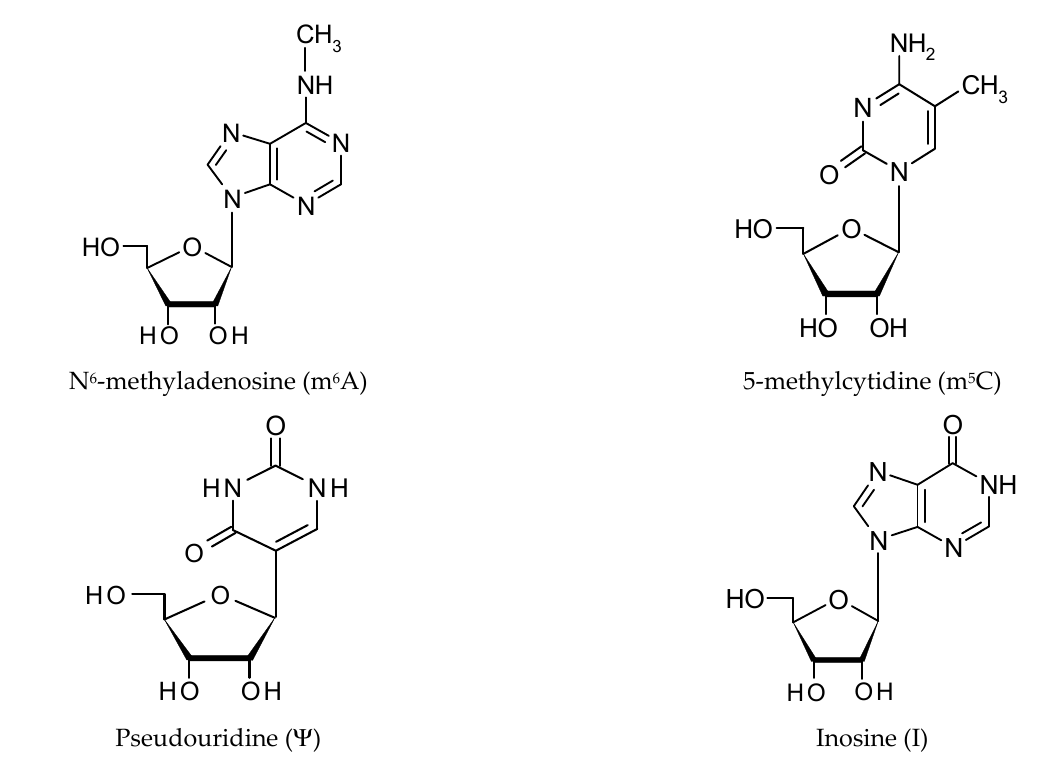
Figure 1. The structure of modified nucleotides found in eukaryotic lncRNA molecules [26–29]. Abundant noncoding RNAs, such as transfer RNAs, ribosomal RNAs and spliceoso- mal RNAs are modified and depend on the modifications for their biogenesis and func- tion. tRNA is one of the most extensively modified RNAs with, on average, 13 modifica- tions per molecule [30]. It is well documented that most tRNA modifications play one of two major roles: (a) stabilizing tRNA’s tertiary structure; and/or (b) aiding in codon–anti-